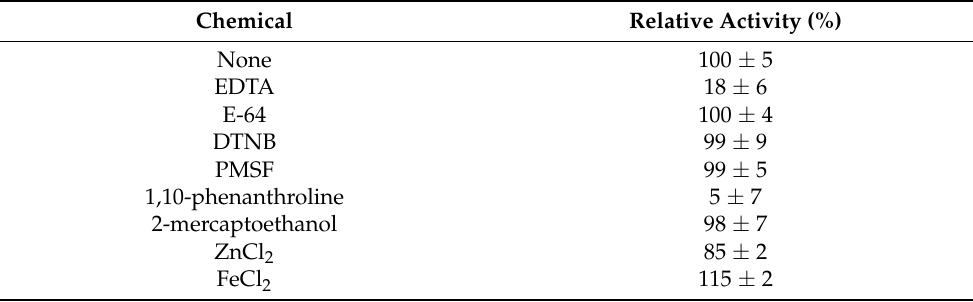
Table 5. Effect of various chemicals on the activity of P. elgii TKU051 protease.